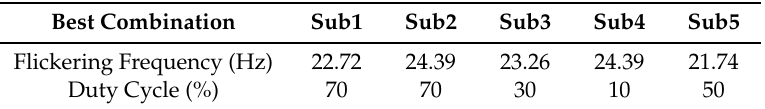
Table 4. Best combination of flickering frequency and duty cycle for each